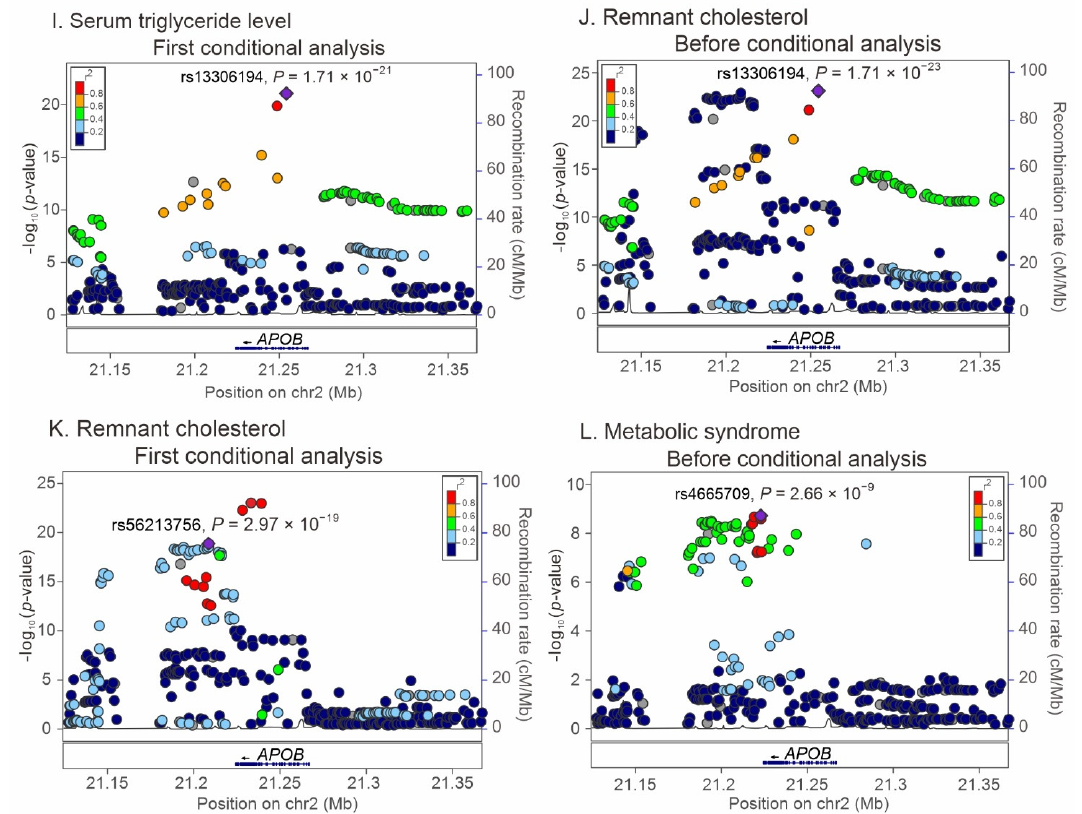
Figure 2. Regional association analysis between APOB variants and lipid profiles and metabolic syndrome.